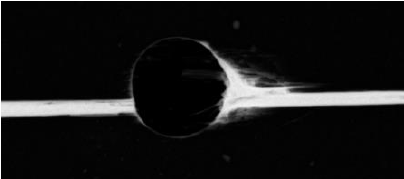
Figure 5. Unidirectional plate after Bearing test — the longitudinal slit is evident.